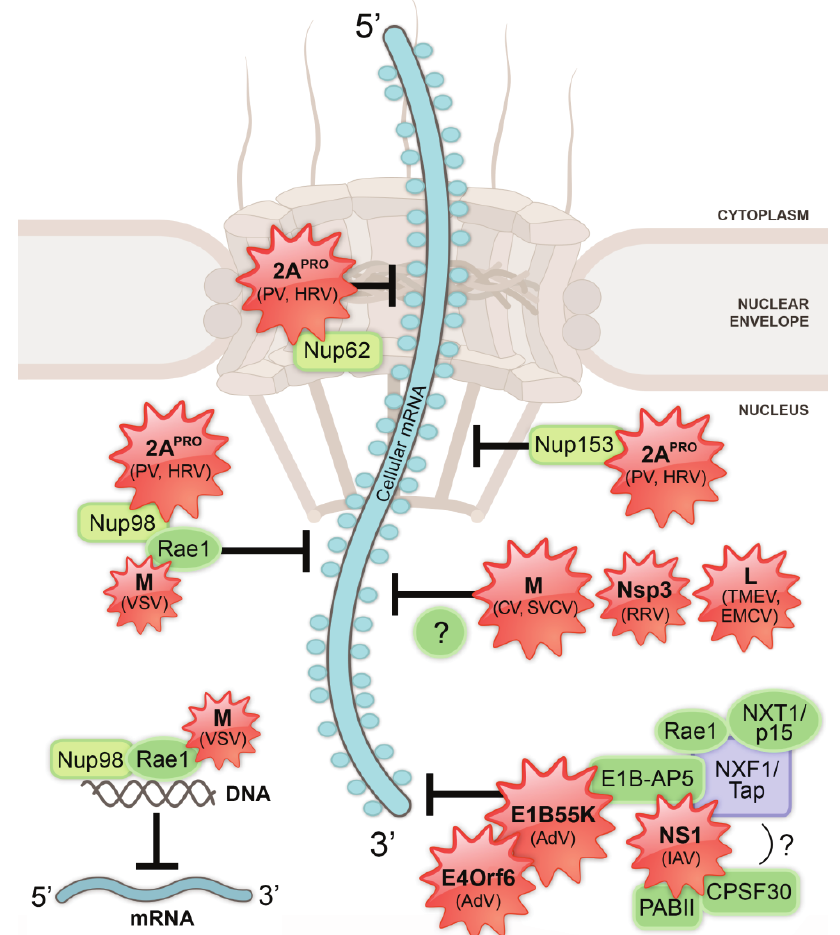
Figure 2. Multiple viruses target cellular mRNA processing and/or export pathways to prevent nuclear export of host mRNA. Processed cellular mRNA associated with RNA-binding proteins (circles encasing the mRNA) is exported from the nucleus through the nuclear pore complexes (NPC) embedded in the nuclear envelope. Viral proteins (red starbursts; viral protein name is bold and virus name is listed in parentheses) disrupt nuclear mRNA processing and export by interacting with host factors (green and purple). These effects promote host shut-off and perturb antiviral signaling, as described in the text. VSV M protein interacts with Rae1 and Nup98, resulting in mRNA nuclear export block. Additionally, this complex may be involved in transcription inhibition of a subset of genes. IAV NS1 binds and disrupts factors involved in cellular mRNA processing and export. CV, SVCV, RRV, TMEV and EMCV inhibit nuclear export of cellular poly(A) mRNA. AdV E1B 55K and E4Orf6 proteins inhibit cellular mRNA export likely by interacting with E1B-AP5 and NXF1/Tap. Abbreviations: PV, poliovirus; HRV, human rhinovirus; VSV, vesicular stomatitis virus; IAV, influenza A virus; AdV, adenovirus; CV, chandipura virus; SVCV, spring viremia carp virus; RRV, rhesus rotavirus; TMEV, Theiler’s murine encephalomyelitis virus; EMCV, encephalomyocarditis virus; 2A PRO , 2A proteinase; M, matrix; NS1, non-structural protein 1; Nsp3, non-structural protein 3; L, leader; Nup,